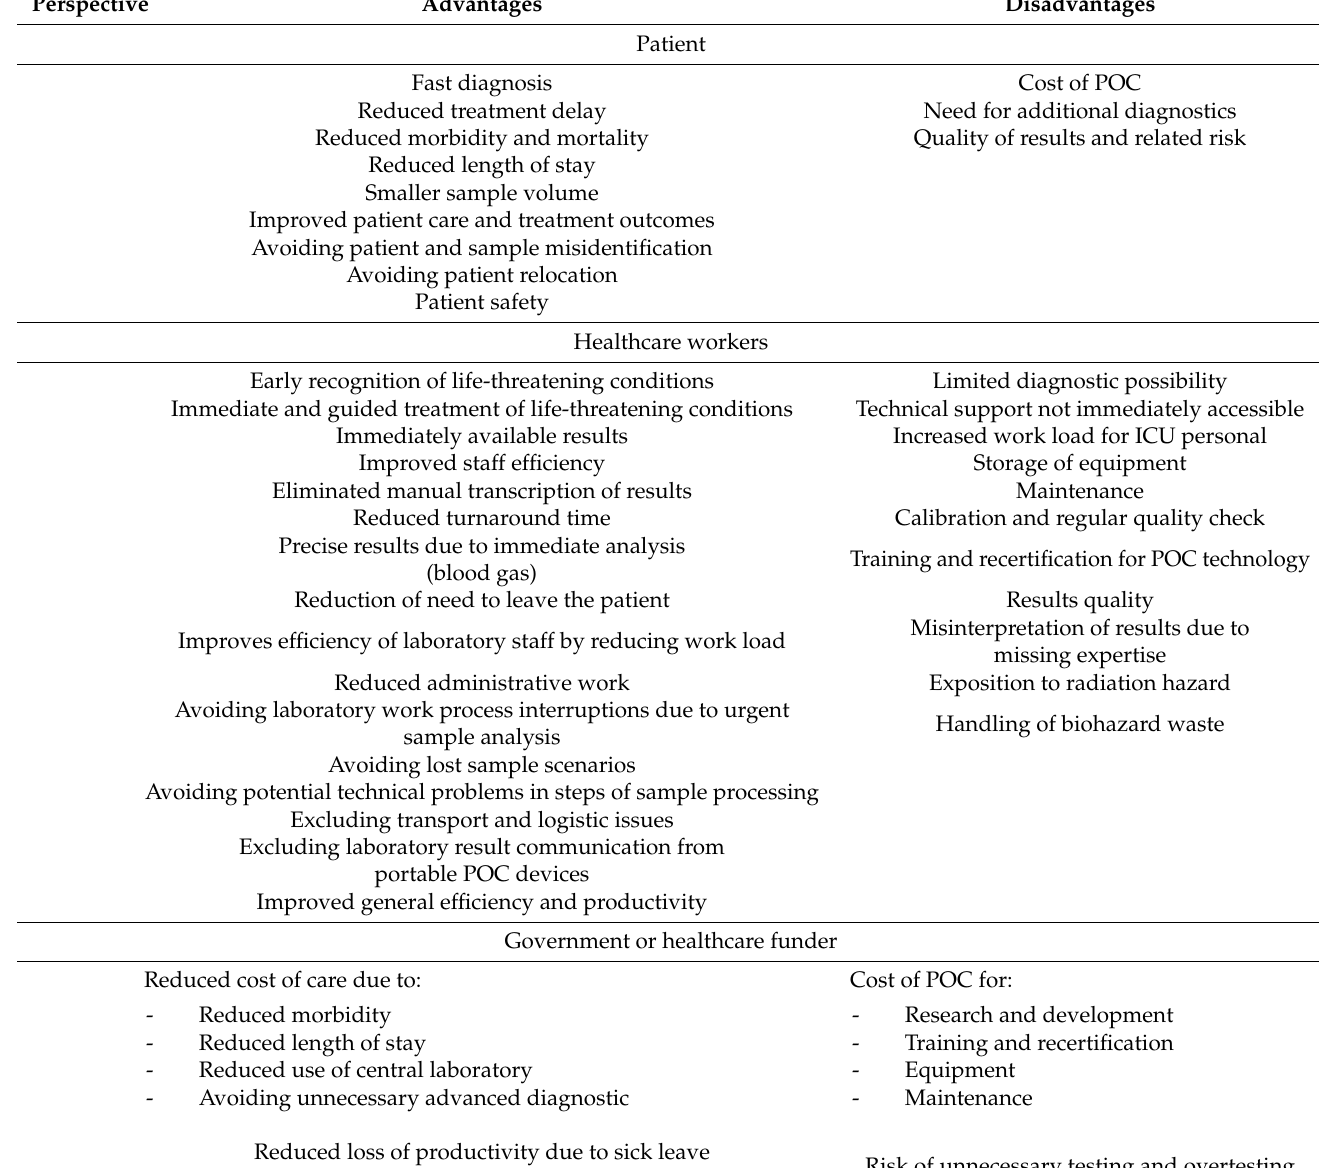
Table 1. Advantages and disadvantages of point-of-care diagnostics in the intensive care